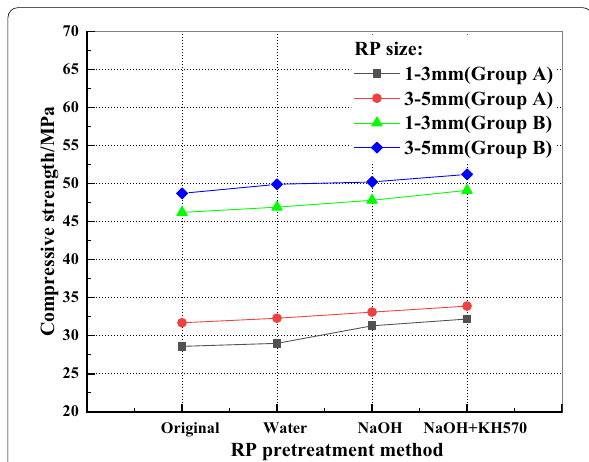
Fig. 8 Effect of different rubber pretreatment methods on the compressive strength